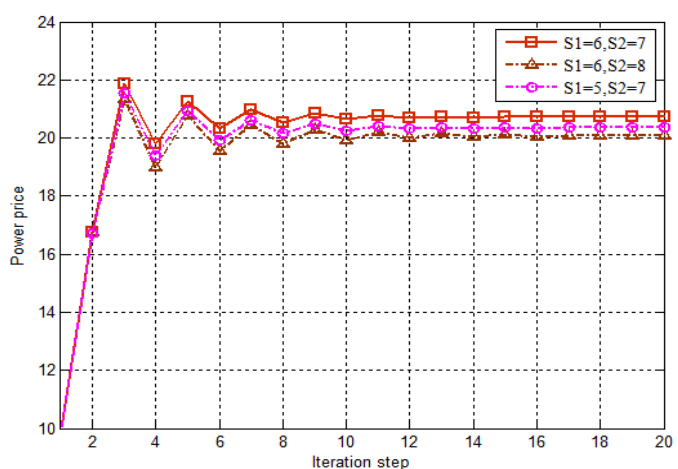
Figure 4. Power price offered by SGO i versus the iteration step, in which its initial price p i = 10 $/MW · h, η 1 = 0.95, η 2 = 0.99, and C 1 = C 2 = 3, respectively.